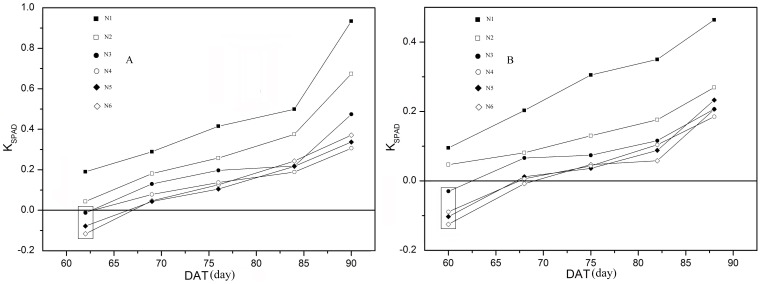
Temporal dynamics of KSPAD in plants grown under different N application rates.KSPAD values were calculated from the data in Fig. 3. Data in the boxes are negative, indicating that SPAD readings increased with increasing canopy depth. N1 to N6 are the same as in the legend in Fig. 1.